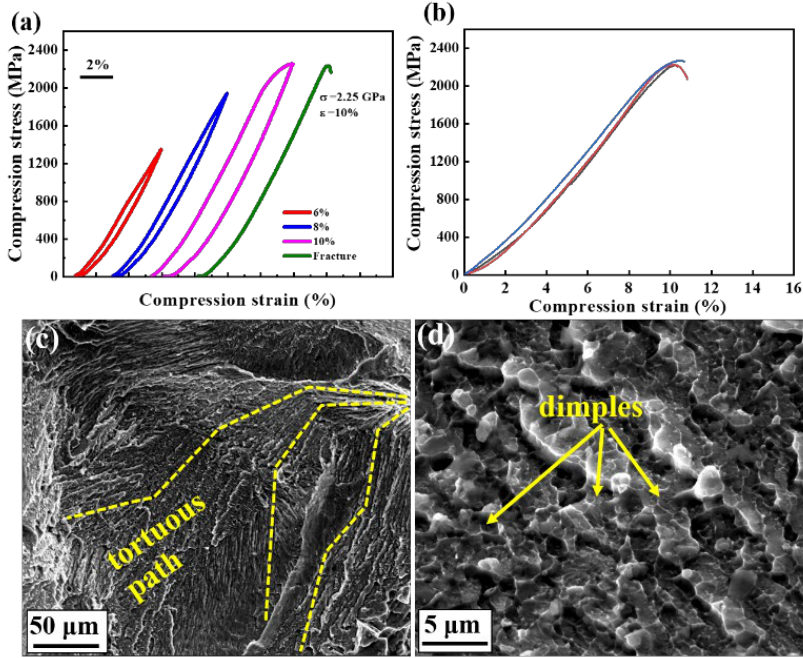
Figure 5. ( a ) Compressive loading–unloading curves of the 60NiTi alloy; ( b ) direct compression fracture curves of the 60NiTi alloy; and ( c , d ) the fracture morphology of the 60NiTi alloy.